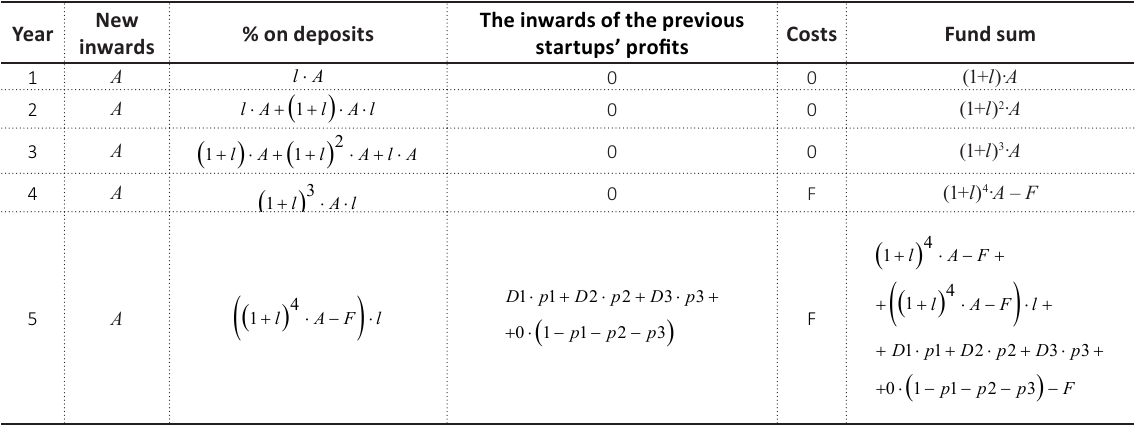
Table 1. The income of the endowment fund by year